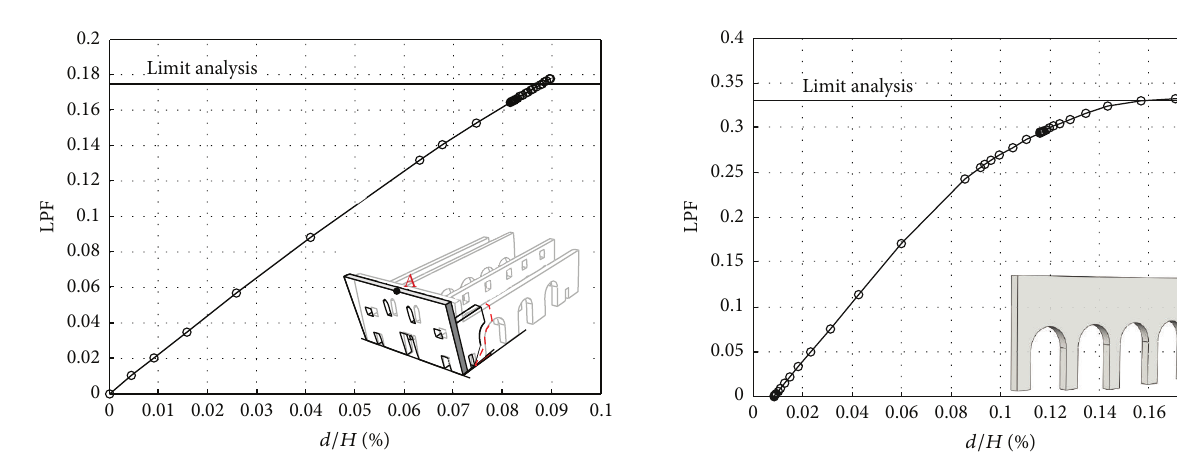
Figure15:Mechanism3:comparisonbetweennonlinearFEanalysis and limit analysis for the in-plane collapse of the nave